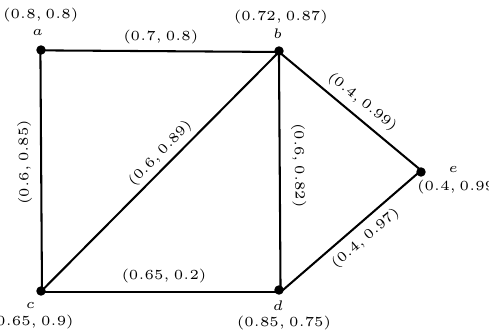
Figure 3.6: A 4-rung orthopair fuzzy graph G